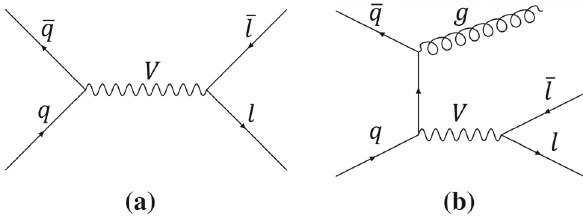
Fig. 1 Tree level diagram ( a ) and example of NLO diagram ( b ) for vector boson V production